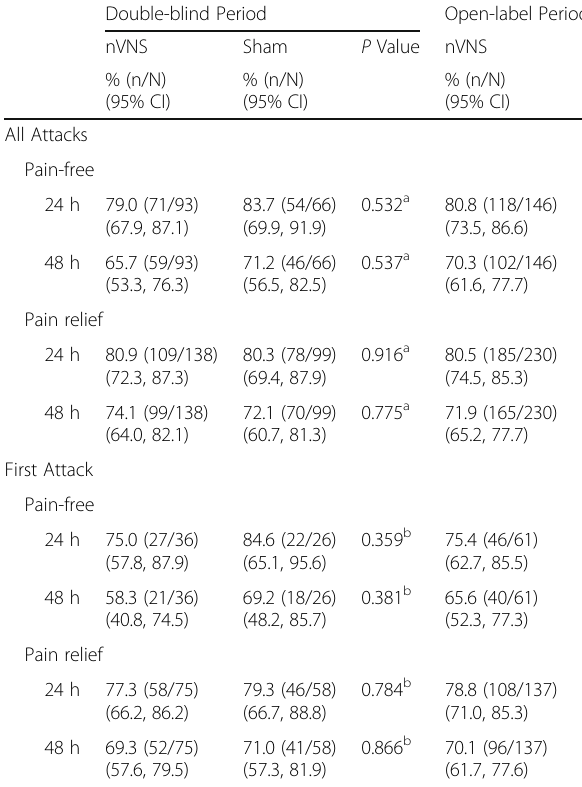
Table 2 Sustained response at 24 and 48 h post-treatment Double-blind Period Open-label